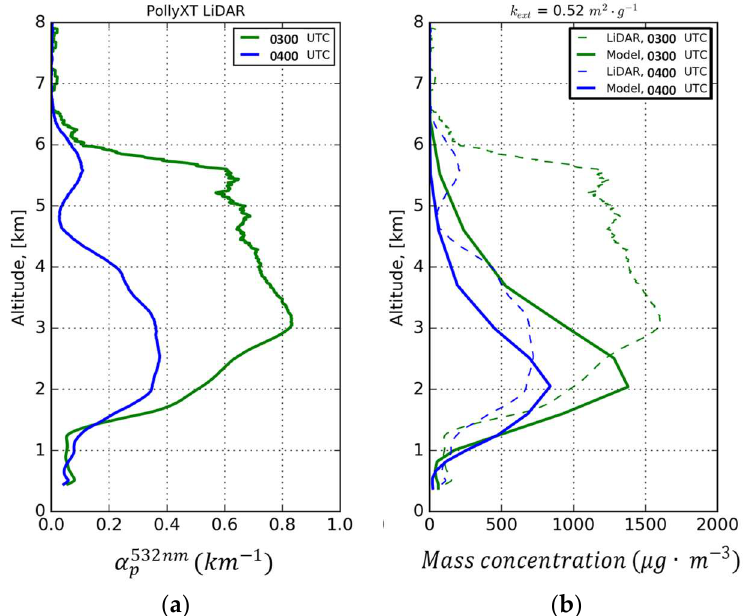
Figure 11. ( a ) PollyXT LiDAR particle extinction coefficient profiles (\alpha_{p}^{532 nm}) at 532 nm and ( b ) mass concentration ( µ g m -3 ), for 0300 and 0400 UTC on 22 March 2018 (green and blue line respectively). The colored dots represent the corresponding in situ PM 10 measurements.